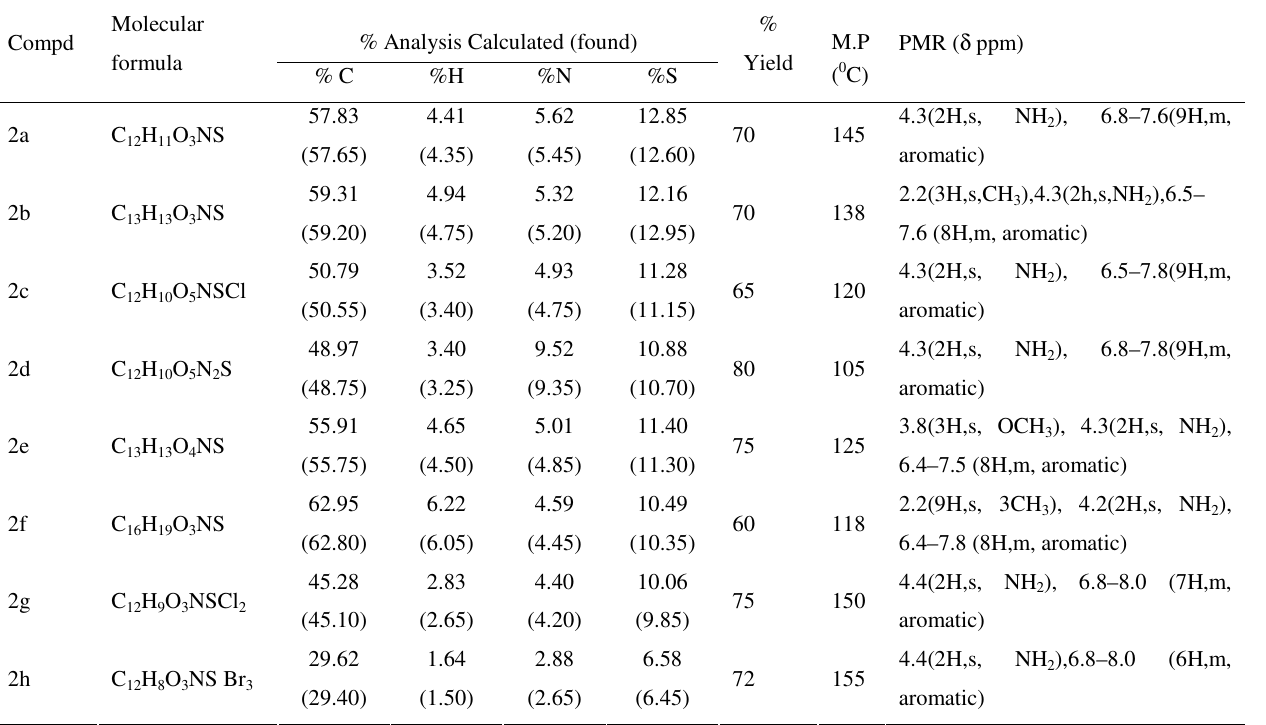
Table 1. Analytical and Spectral data of compounds (2